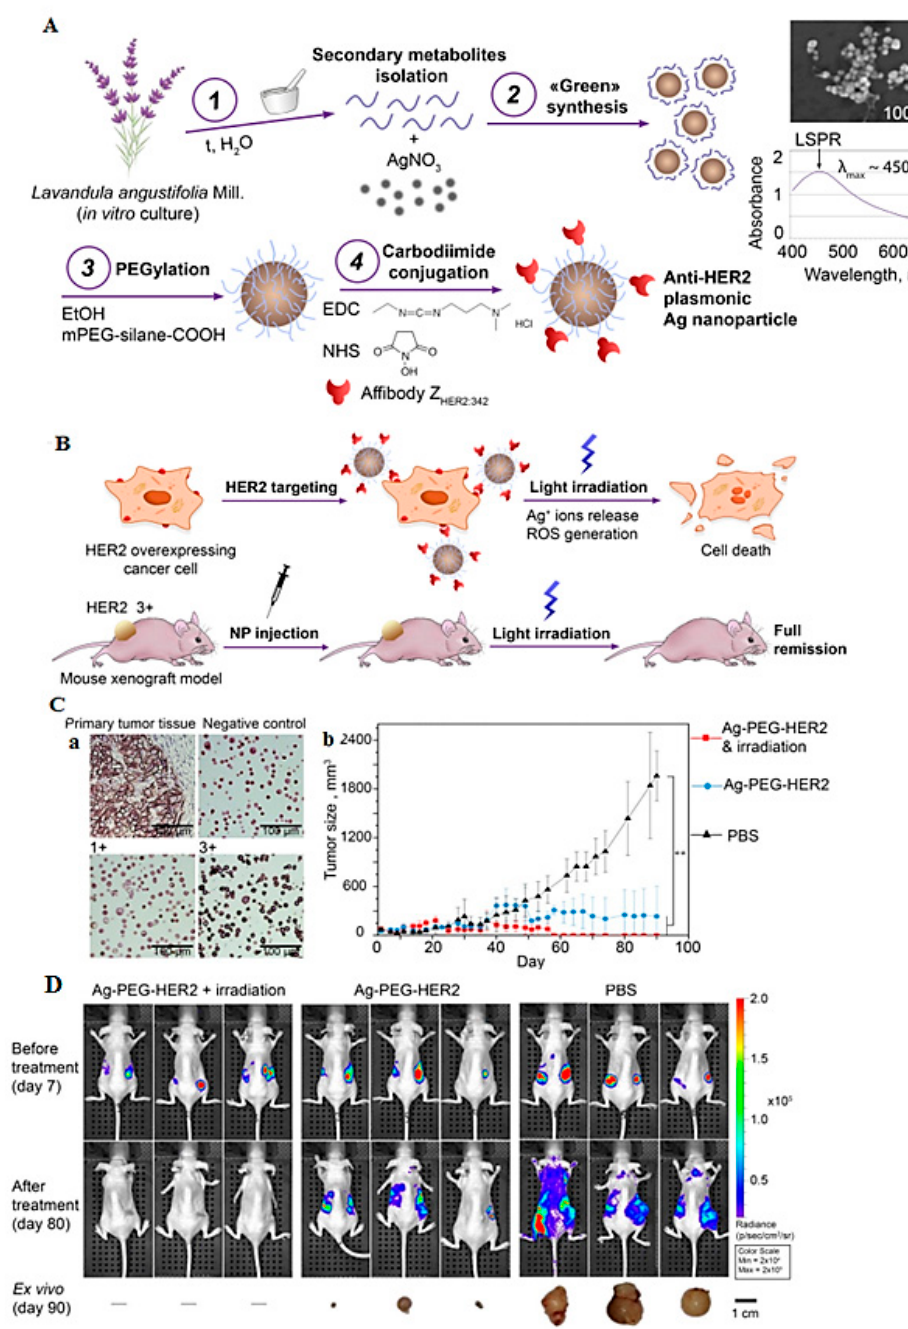
Figure 4. ( A ) The preparative process of Ag-PEG-HER2 NPs. ( B ) Photothermal-induced death of cancer cells via targeted delivery of functionalized Ag NPs to specific cells under the light irradiation, causing Ag + ions release and ROS generation with total tumor elimination. ( C - a ) Immunohisto- chemistry of primary tumor tissue and Hercep Test controls: negative HER2 expression (1+) and HER2 overexpression (3+). ( C-b ) Dynamics of tumor growth under the treatment with injections of phosphate-buffered saline (PBS), Ag-PEG-HER2 NPs, and Ag-PEG-HER2 with 1 h post blue light irradiation. ( D ) Bioluminescent imaging of BT/NanoLuc xenograft tumors before treatment on day 7 and after treatment on day 80, as well as ex vivo imaging of primary tumors (day 90). Adapted from Ref [71] with permission (CC BY) Copyright 2022 Multidisciplinary Digital Publishing Institute